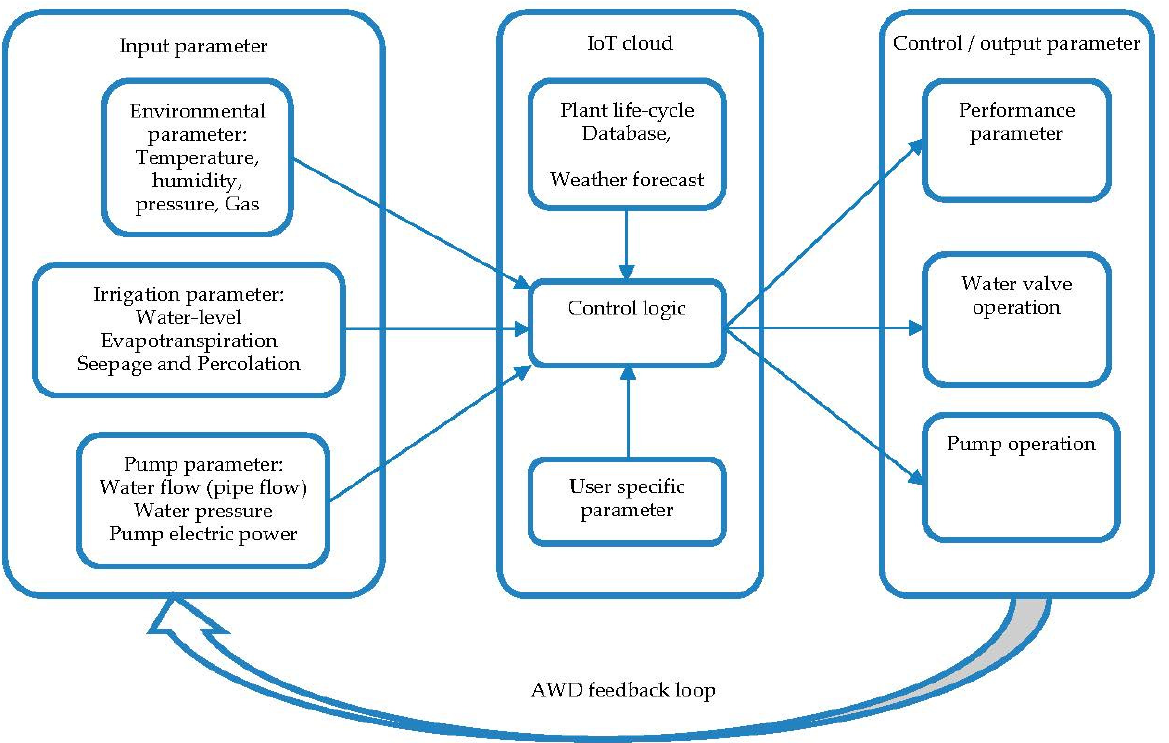
Figure 3. Functional blocks of the IoT–WSN-based AWD automation control loop.